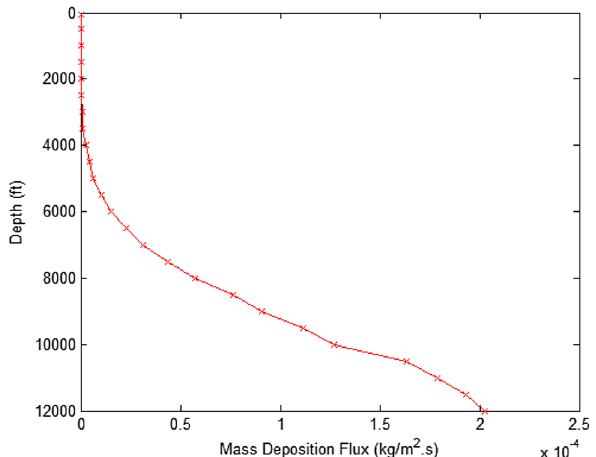
Fig. 13 Profile of asphaltene mass deposition flux